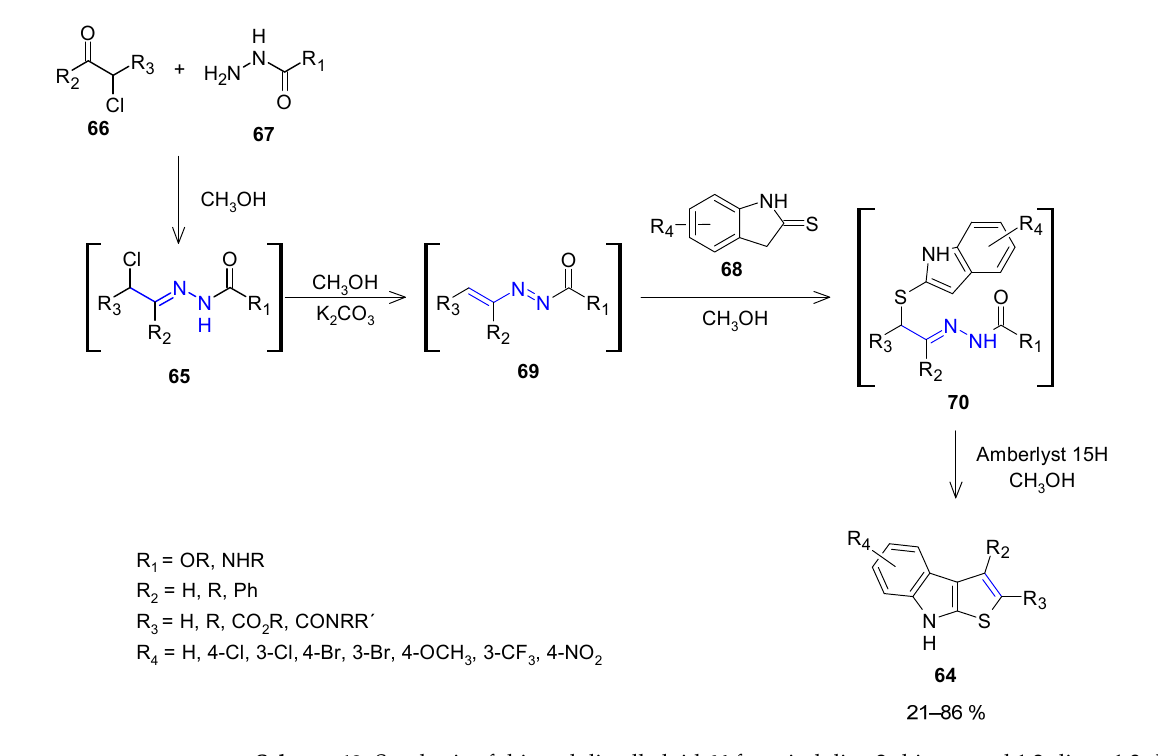
Scheme 13 . Synthesis of thienodolin alkaloid 64 from indoline 2 ‐ thiones and 1,2 ‐ diaza ‐ 1,3 ‐ dienes.